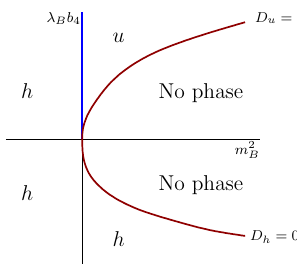
Figure 6 . Phase diagram for x 6 > (cid:30) 2 . The positive (cid:21) B b 4 axis (shown in blue) corresponds to a second-order phase